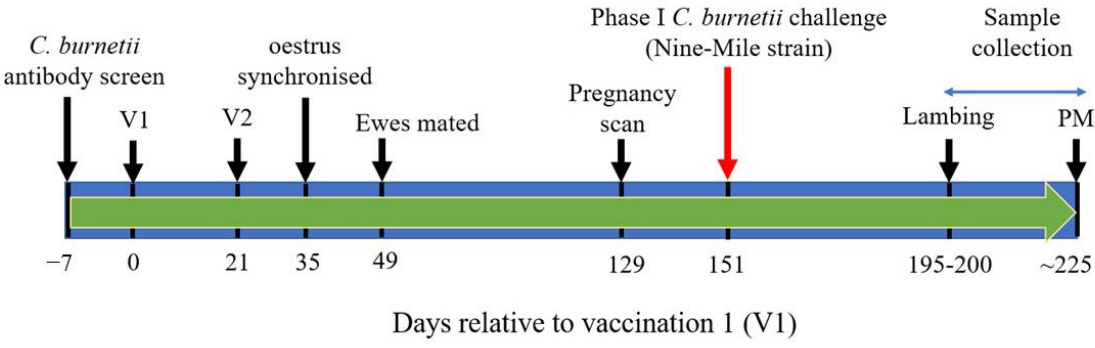
Figure 1. Immunization and C. burnetii challenge schedule. V1 and V2 = vaccination 1 and 2, respectively; PM = post-mortem.